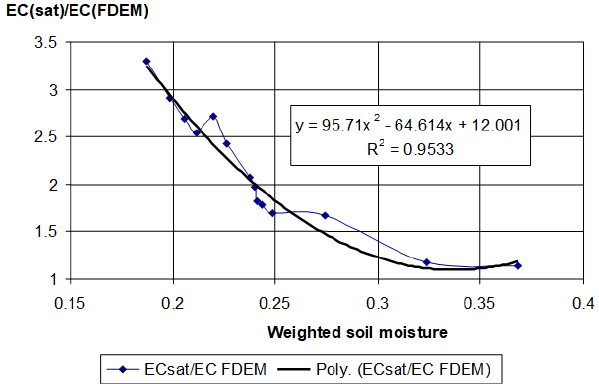
Figure 12. Correlation between the ratio of EC (sat) to EC FDEM and the weighted soil moisture at the Kibbutz Meirav mature olive plantation test site.